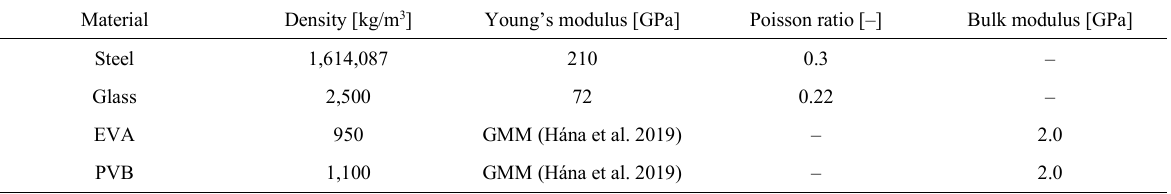
Table 3: Material parameters for the impactor, glass, and polymers.